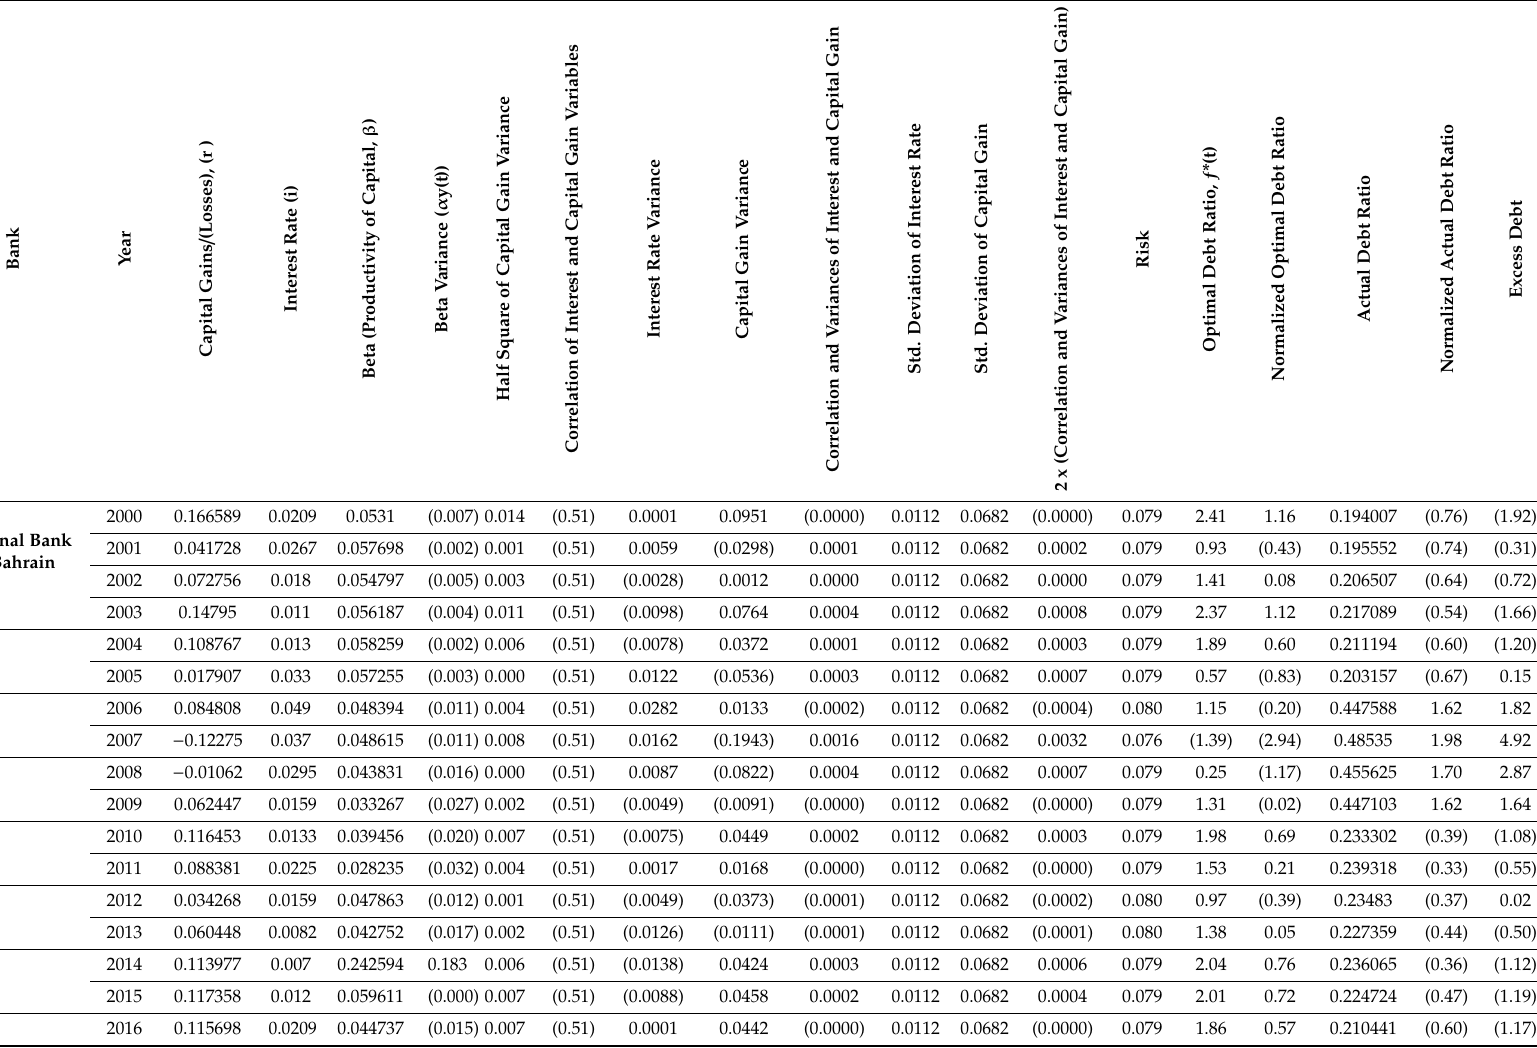
Table A3. Calculations of Optimal and Excess Debt: National Bank of